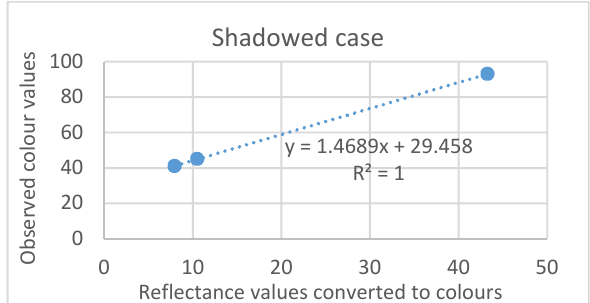
Figure 2. The regression for finding coefficients of a linear transformation in the shadowed case. The blue dots from left to right correspond to colours red, green and NIR,